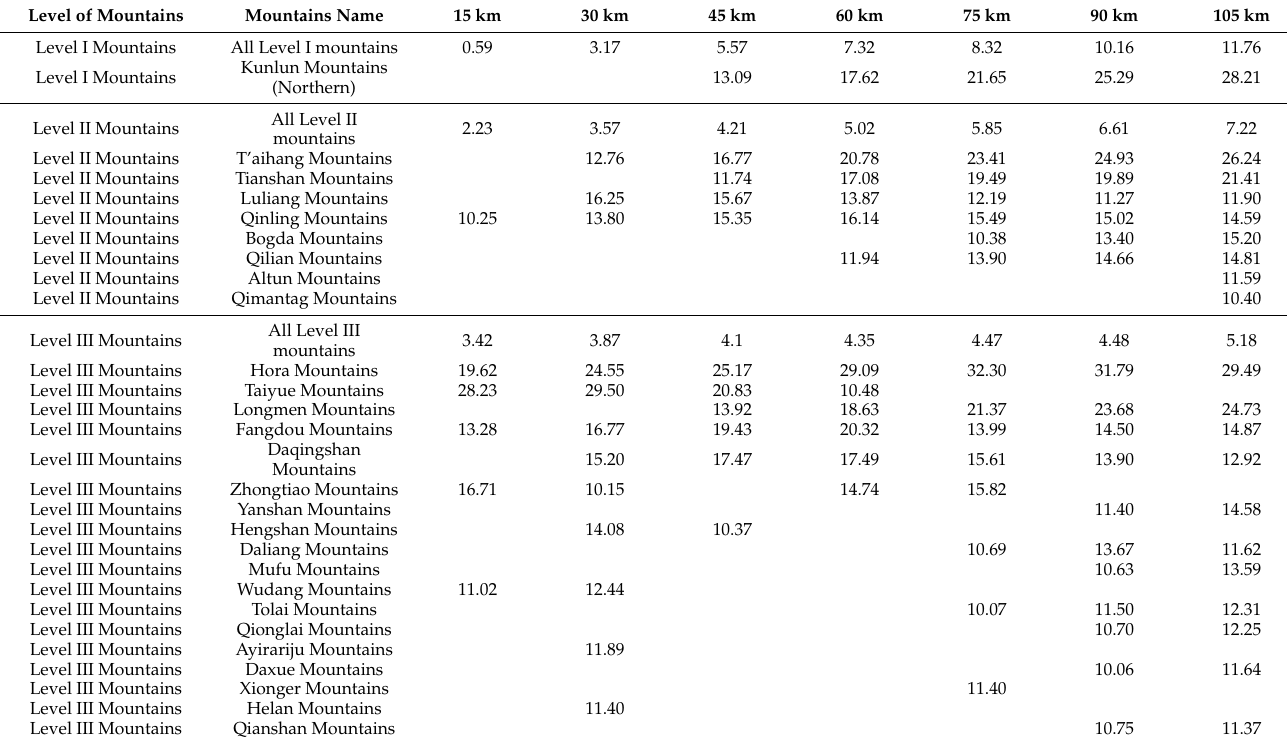
Table 2. The absolute PM 2.5 concentration differences between the two sides of Level I–III mountains at different buffer zones. We first calculated the absolute PM 2.5 concentration differences between the two sides of each mountain, and the absolute values of all the mountains at each level were then averaged and are provided in the table below. As there are many mountains, only the mountains with absolute PM 2.5 concentration differences between their left and right sides greater than 10 µ g/m 3 were typically shown in the table below, and these mountains were taken as the typical